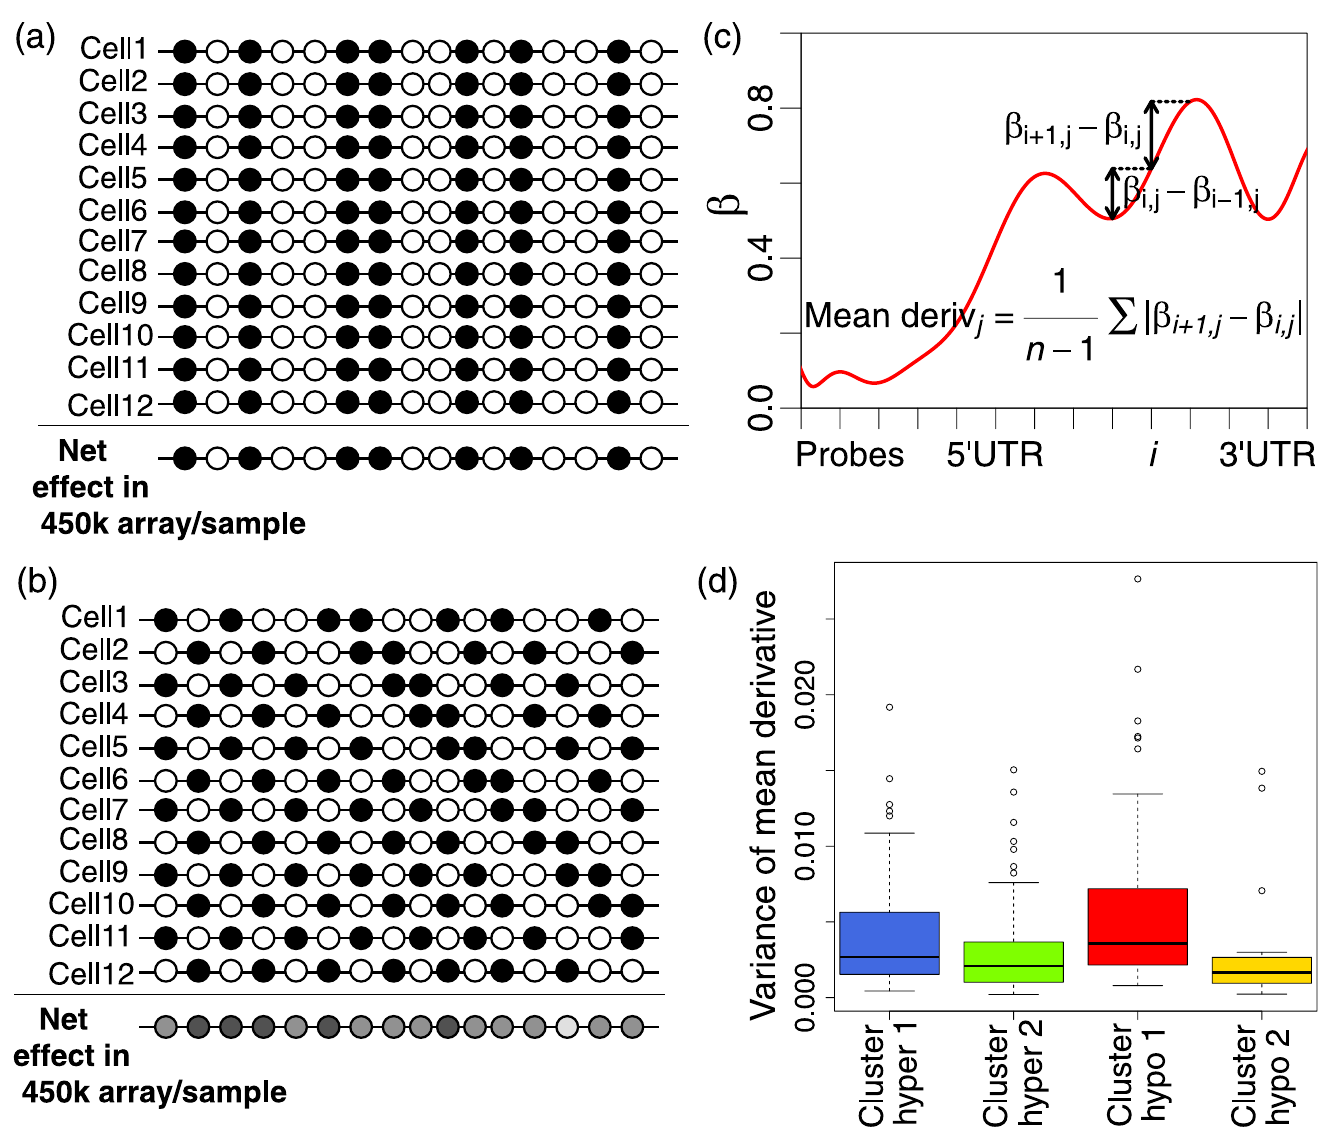
Fig 5. Heterogeneity and the effects of cell mixing on the 450K array. The 450K array provides methylation measurements from a mixed-up sample of multiple cells. (a) An example of a methylation pattern which is highly variable, in a similar way across cells. This leads to low cross-sample heterogeneity, and high IGV, as in cluster hyper 2. (b) An example of a methylation pattern which is highly variable, but in a heterogenous way across cells. This leads to high cross-sample heterogeneity, however the net effect of averaging the methylation profiles across the mixed up sample of many cells gives a measurement with low IGV, as in cluster hypo 1. (c) A measure of CpG-CpG methylation variability, calculated as the mean derivative, or the mean absolute difference in methylation level between adjacent CpGs. (d) The variability of the mean-derivative measure across samples quantifies the heterogeneity of the CpG-CpG methylation variability. Cluster hyper 2 is low according to (d), and hence corresponds to a pattern such as (a). Cluster hypo 1 is high according to (d), and hence corresponds to a pattern such as